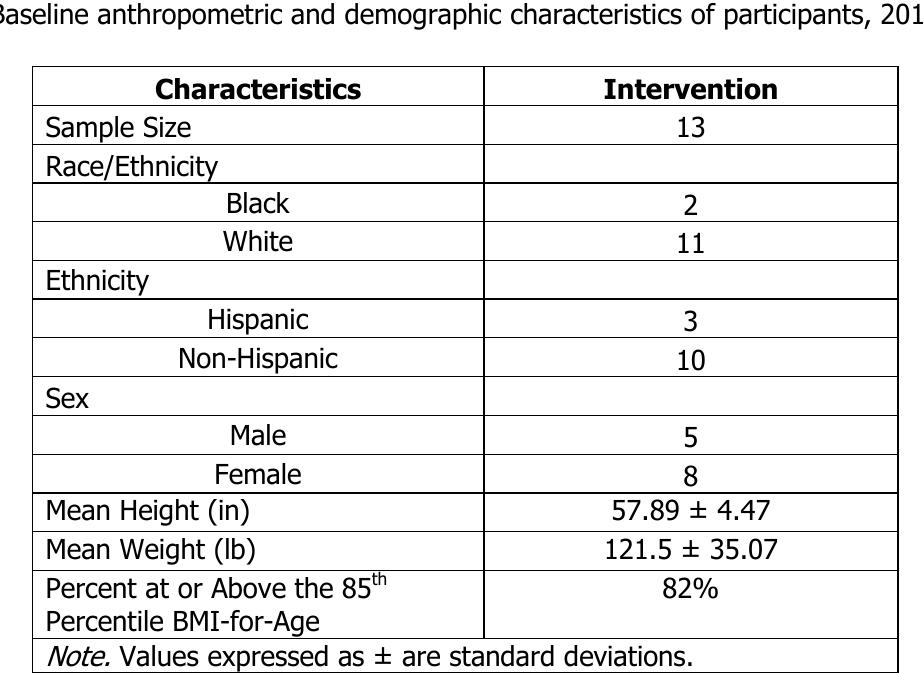
Baseline anthropometric and demographic characteristics of participants,